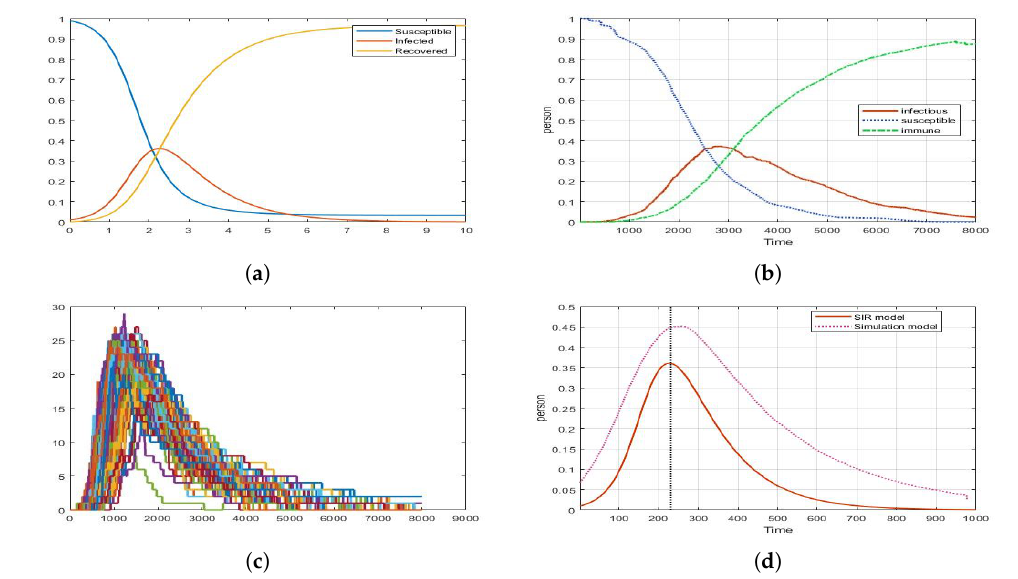
Figure 5. Graph of SIR model and simulation model when R 0 = 3.4: ( a ) SIR model ( R 0 = 3.4); ( b ) simulation model ( R 0 = 3.4); ( c ) dynamics of Infected in simulation model (100 reps); ( d ) dynamics of infected that matches the peak point through time